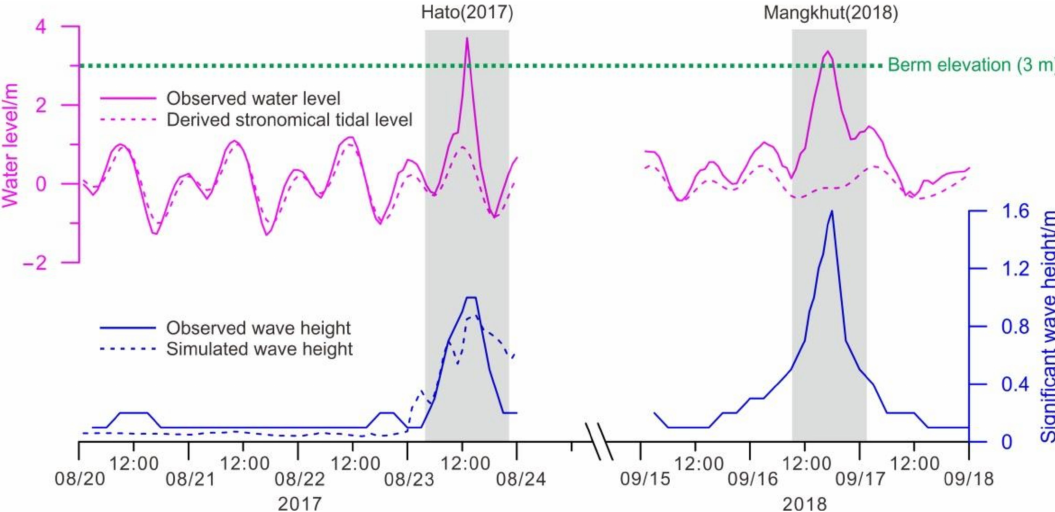
Figure 5. Observed and simulated water levels ( upper panel ) and significant wave heights ( lower panel ) near ML beach during Typhoon Hato (2017) and Mangkhut (2018). Grey bands highlight the period in which storms induced significant hydrodynamic